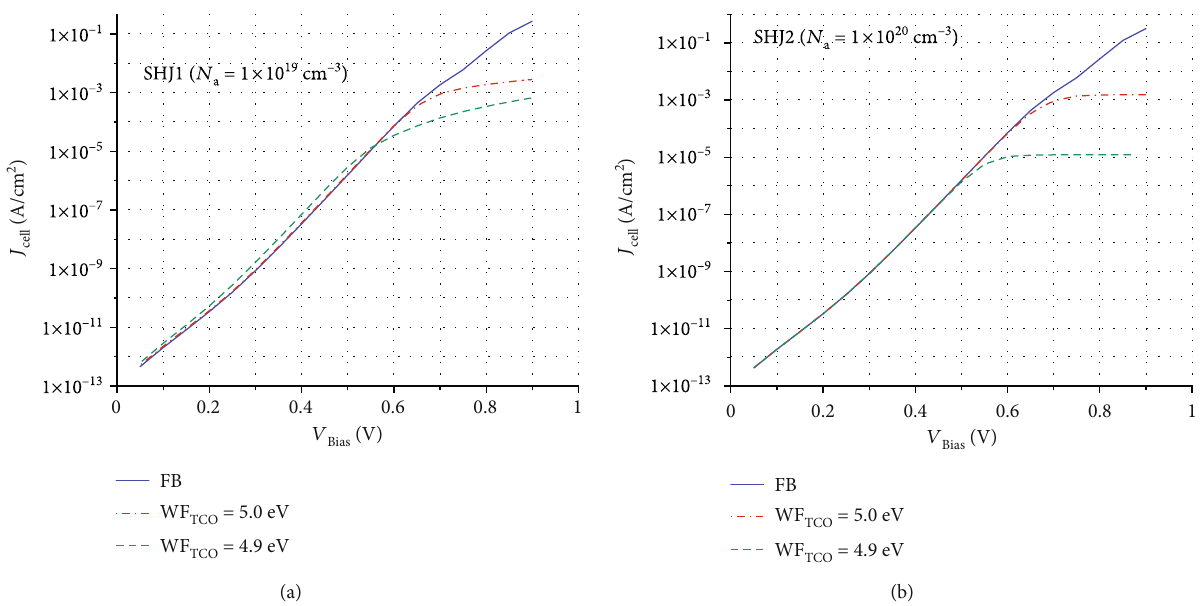
Figure 3: Simulated I-V characteristics for SHJ1 (a) and SHJ2 (b) under dark conditions with WF 5.025eV and 4.96eV. A drift-di ff usion model is invoked, and thermionic emission across the heterointerface is